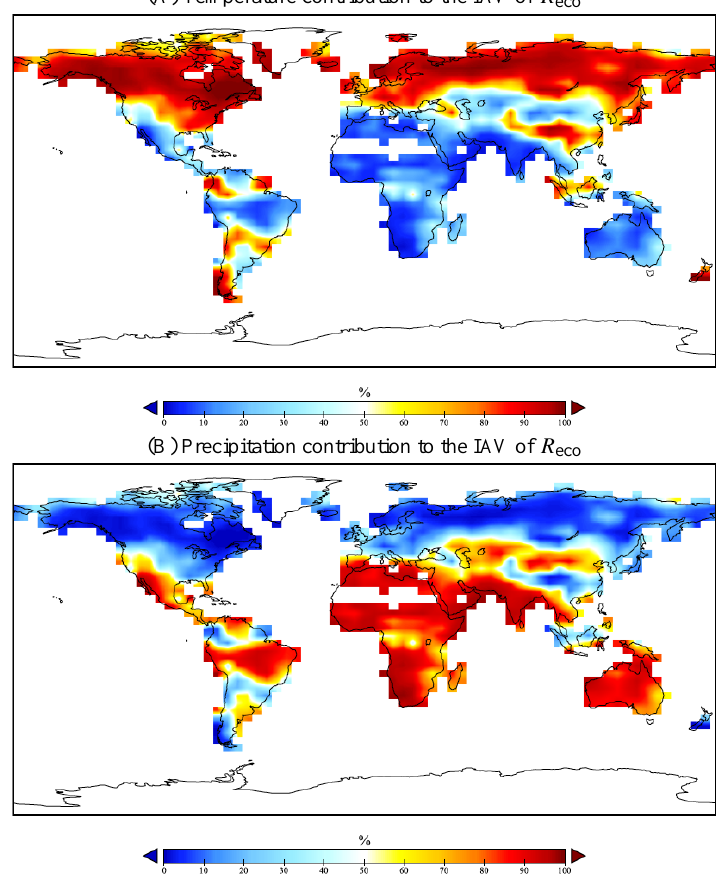
Fig. 11. The global distribution of the relative contribution of each climate variable ( (A) temperature: high values indicate LOW temperature is limiting, (B) precipitation: high values indicate LOW precipitation is limiting) to the interannual variability (IAV) of R eco